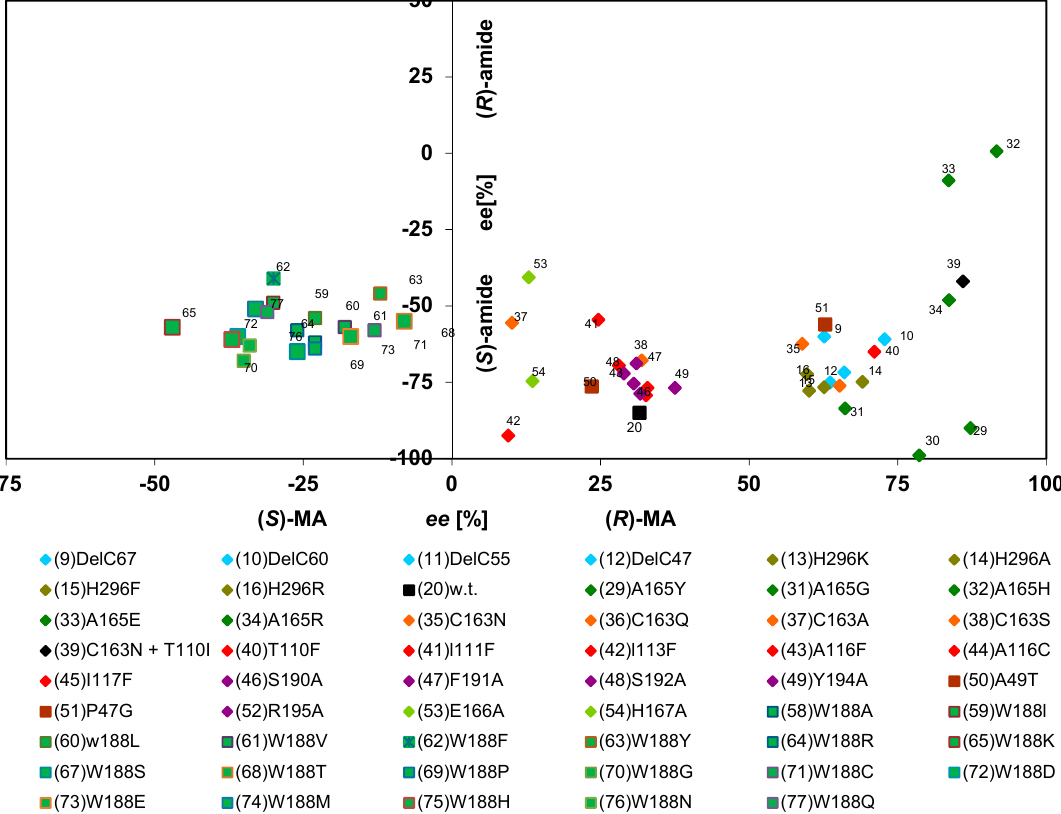
Figure 10. Correlation of the enantiomeric composition of the amides and acids formed from ( R , S )-mandelonitrile by various nitrilase variants. The data were taken from previous publications (see Figure 6). But those variants were excluded from the analysis which formed less than 2% of mandelamide (in relation to the amounts of mandelic acid formed).